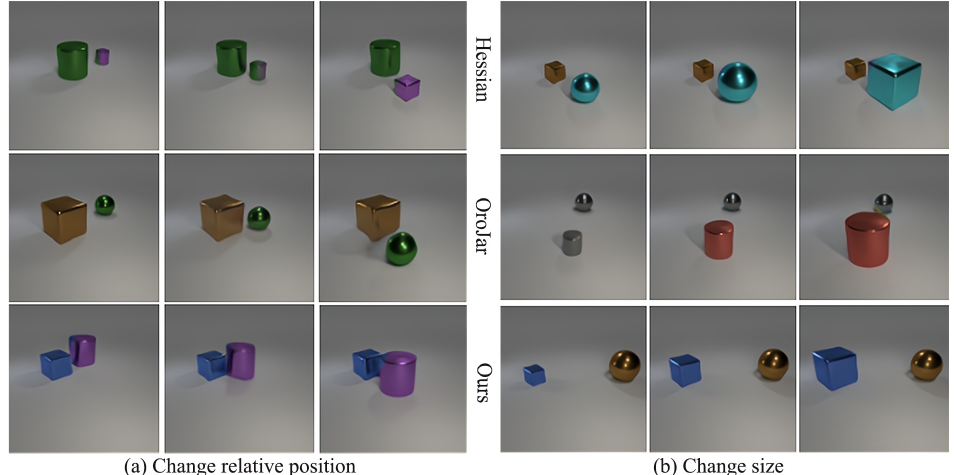
Figure 8. Comparison of disentanglement the quality of the CLEVR complex by our method, Hessian penalty [13], and OroJaR